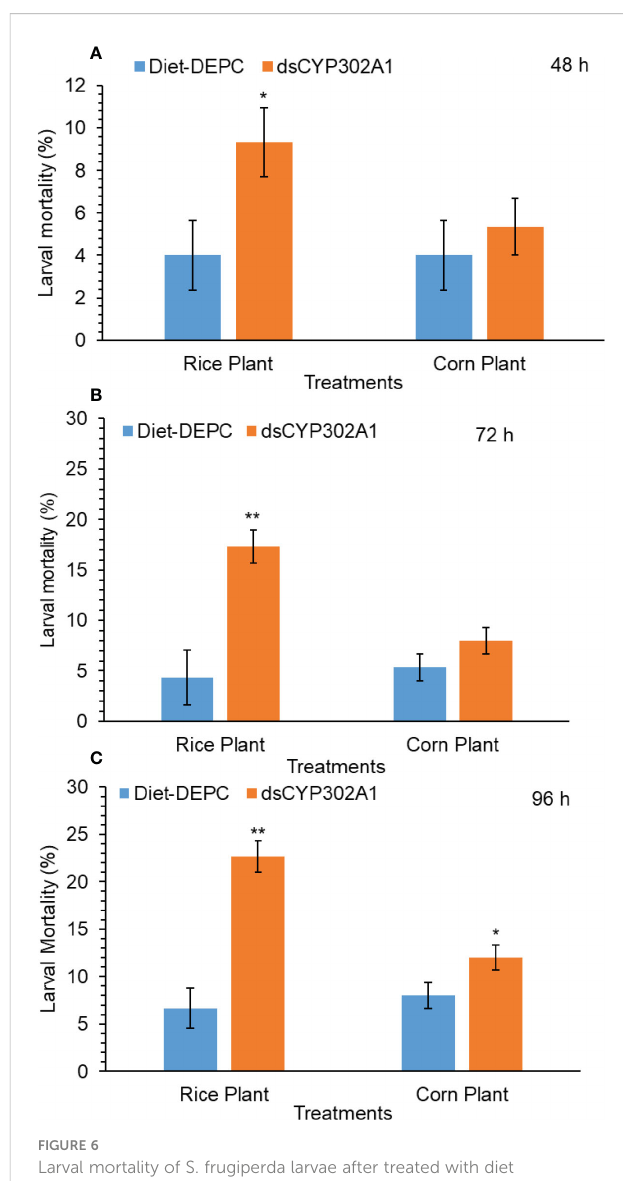
FIGURE 6 Larval mortality of S. frugiperda larvae after treated with diet containing dsCYP302A1and DEPC-treated water followed by feeding on rice and host plants for 48 (A) , 72 (B) and 96 h (C) . Data shown are mean ± SE. Treatments were compared using Student ’ s t test. * and ** represent P < 0.05 and P < 0.01,